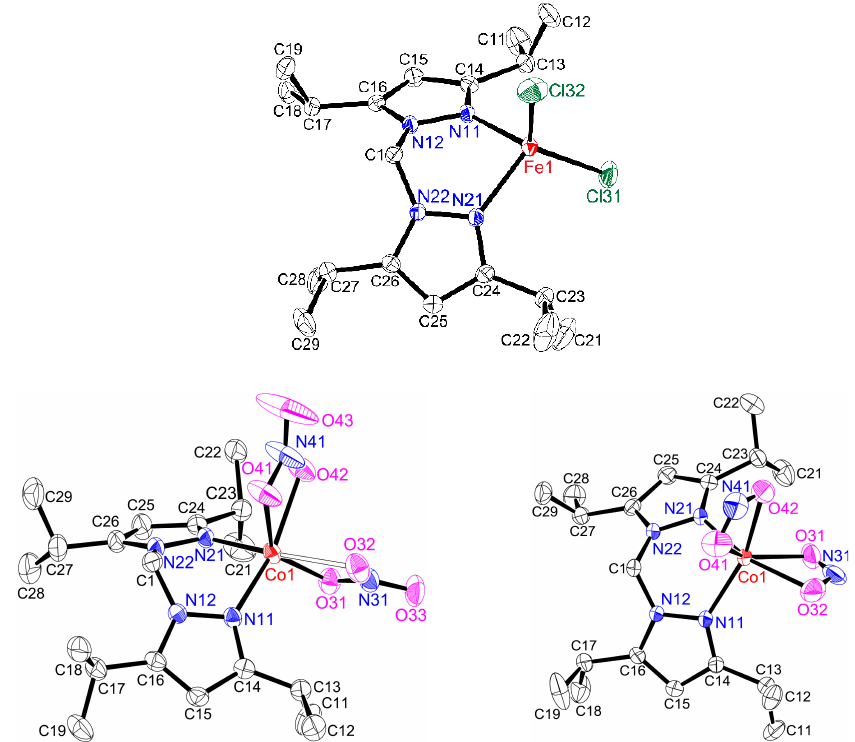
Figure 2. Crystal structures of [FeCl 2 (L1”)] (top), [Co( κ 2 -O 2 NO) 2 (L1”)] (bottom, left), and [Co( κ 2 -O 2 N) 2 (L1”)] (bottom, right) showing 50% displacement ellipsoids and the atom labeling scheme. Hydrogen atoms and solvents were omitted for reasons of clarity. Relevant bond lengths (Å) and